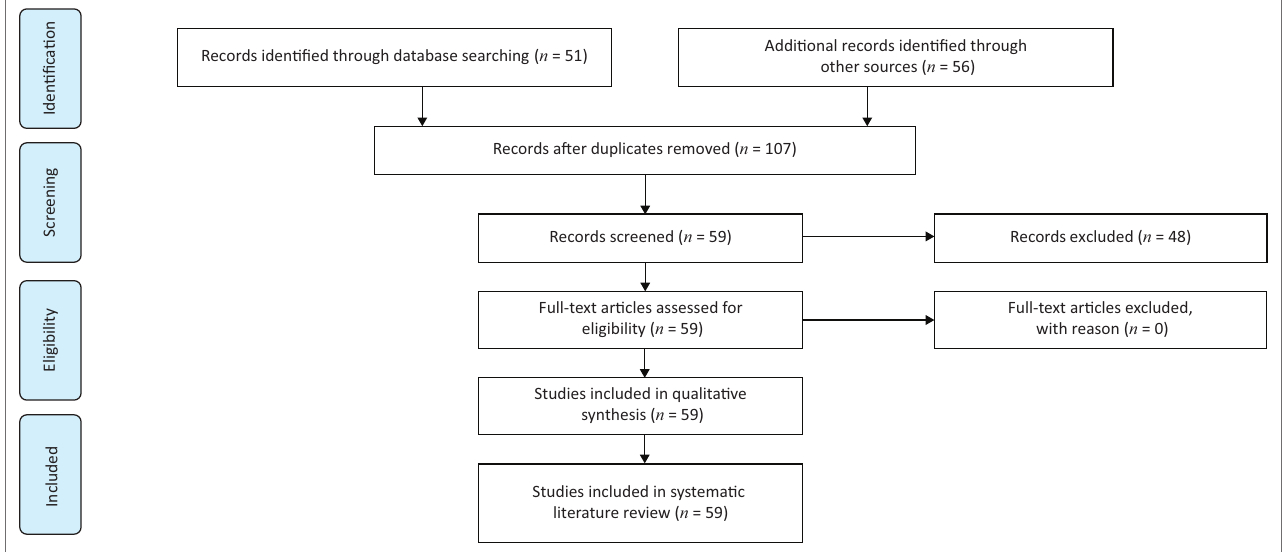
FIGURE 2: Prisma flow diagram illustrating the decisions